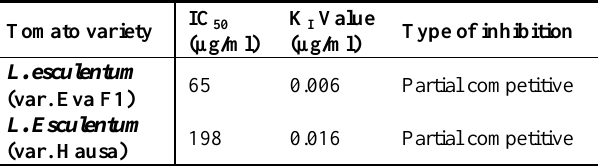
Table 4 : Michaelis-Menten parameter (Ki), and IC of inhibitors.